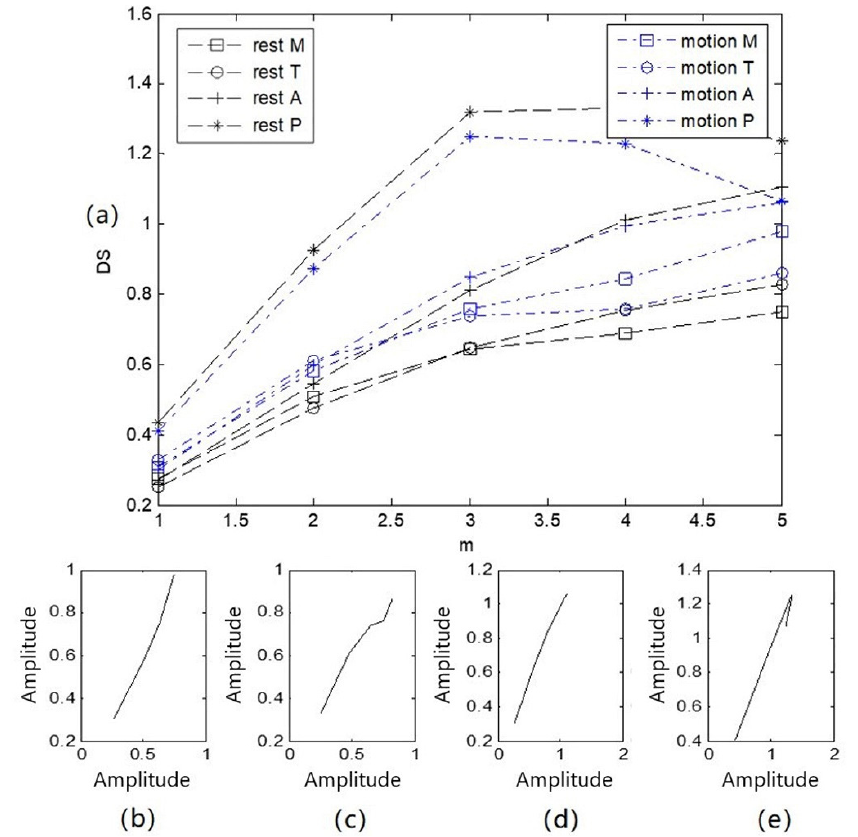
Figure 8. Trend diagram and similarity phase diagram of heart sounds in 2 states: ( a ) a state variation trend diagram of 4-channel heart-sound signals under 2 states; ( b ) similarity phase diagrams of Rest M and Motion M; ( c ) similarity phase diagrams of Rest T and Motion T; ( d ) similarity phase diagrams of Rest A and Motion A; ( e ) similarity phase diagrams of Rest P and Motion P.